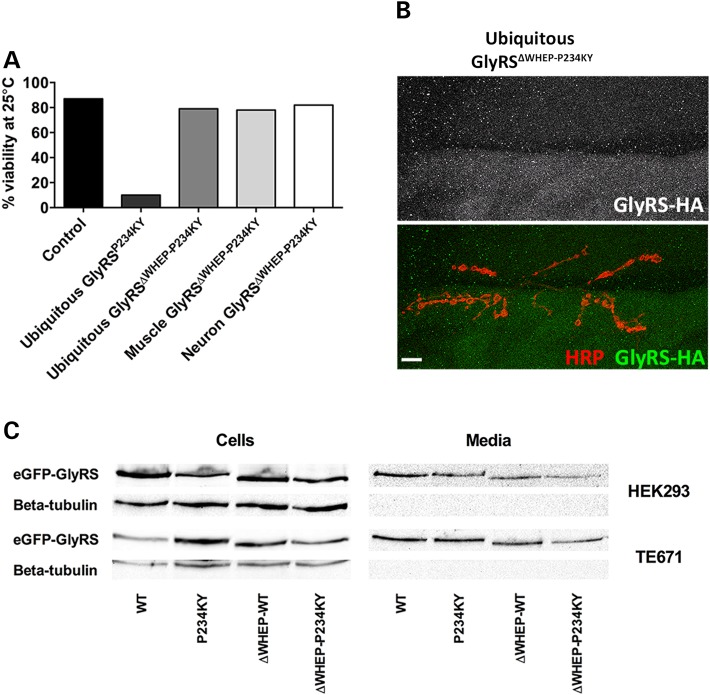
GlyRS toxicity and synapse binding, but not secretion, are dependent on the WHEP domain. (A) Removal of the WHEP domain abrogated the pathology associated with both ubiquitous and muscle expression of mutant gars in vivo; garsΔWHEP-P234KY expression had no effect on larval viability. (B) GlyRSΔWHEP-P234KY did not associate with the neuronal membrane (using non-permeabilization conditions). (C) To determine whether WHEP deletion restricts GlyRS secretion and is the principal cause of the abolished mutant pathology, eGFP-tagged GARSWT and GARSP234KY with or without the WHEP domain were expressed in human kidney (HEK293) and muscle-like (TE671) cells. Deletion of the WHEP domain did not affect secretion of wild-type or mutant GlyRS. The localization of all GlyRS proteins was similar in both cell lines and with each protein tag (data not shown). Scale bars = 10 µm.